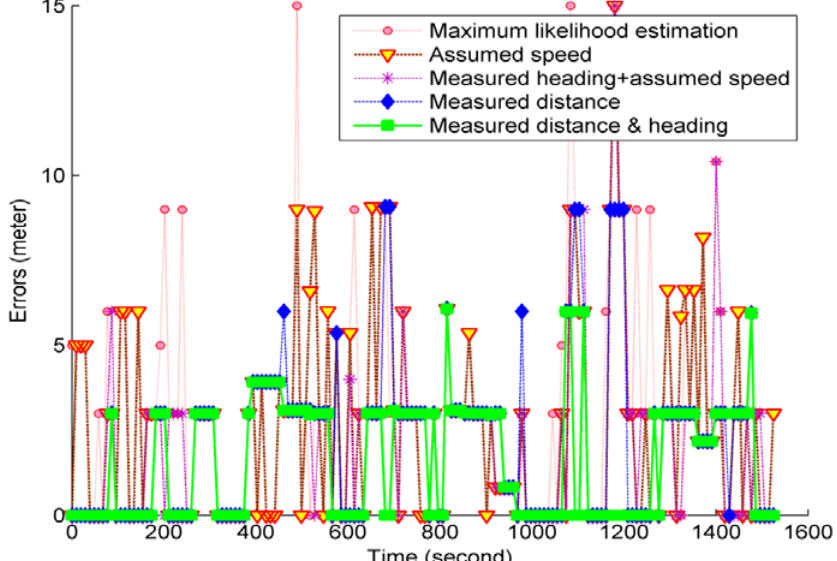
Figure 10. The epoch-by-epoch positioning errors of the HMM solutions and the MLE solution. The HMM solutions use different combinations of MDI as defined in Table 1 and utilize the grid-based filter algorithm to produce position estimates.